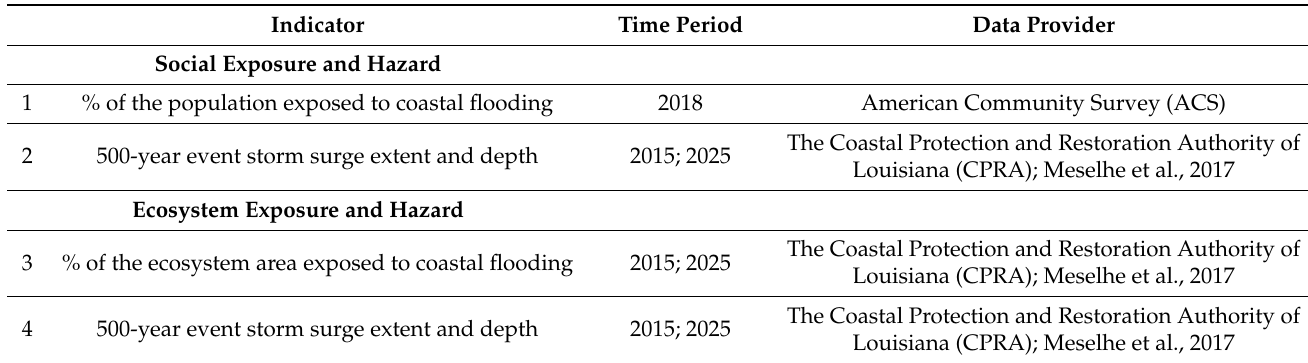
Table 2. Exposure and hazard component indicators used in the GDRI coastal flood risk assessment. Exposure and hazard data are combined with coastal flood vulnerability indicators (Table 1) to calculate coastal flood risk. Hazard data, also used to calculate social and ecosystem exposure, are integrated into the GDRI using 2015 data and modelled future scenario data to year